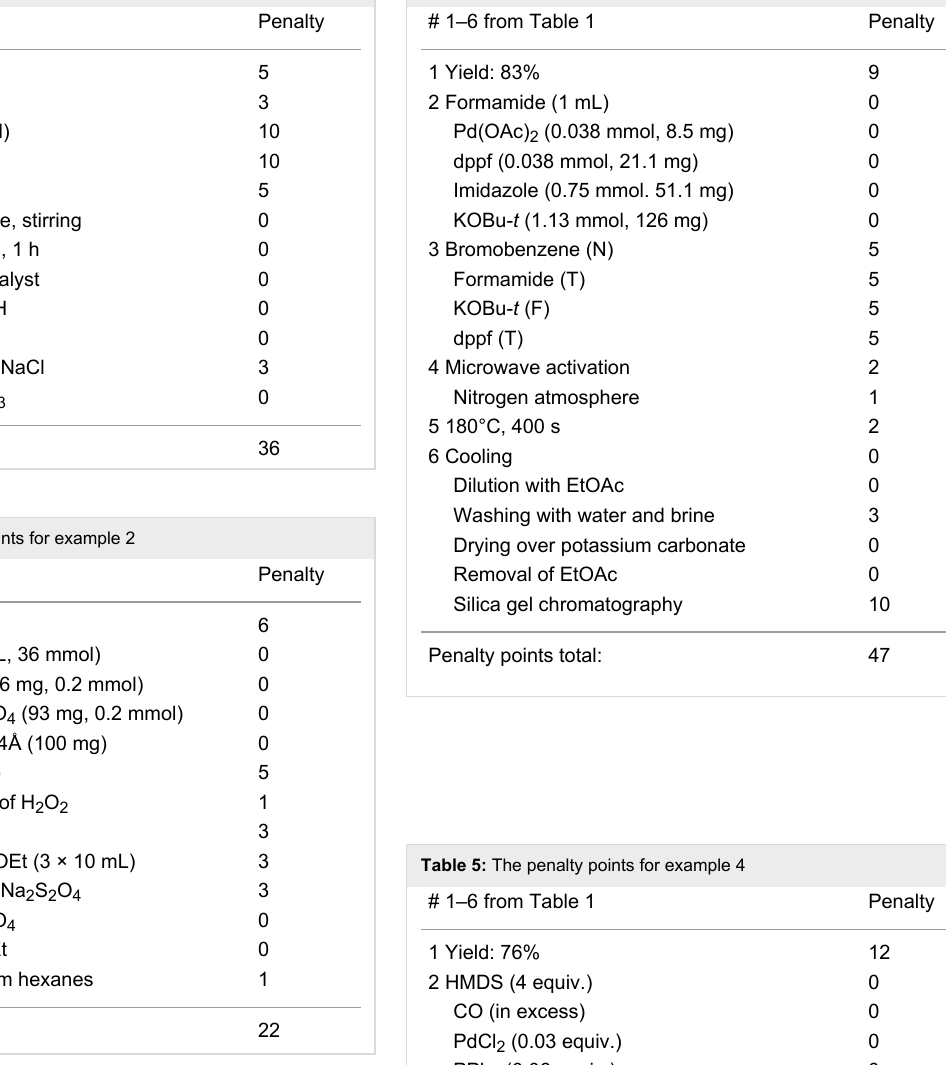
Table 4: The penalty points for example 3